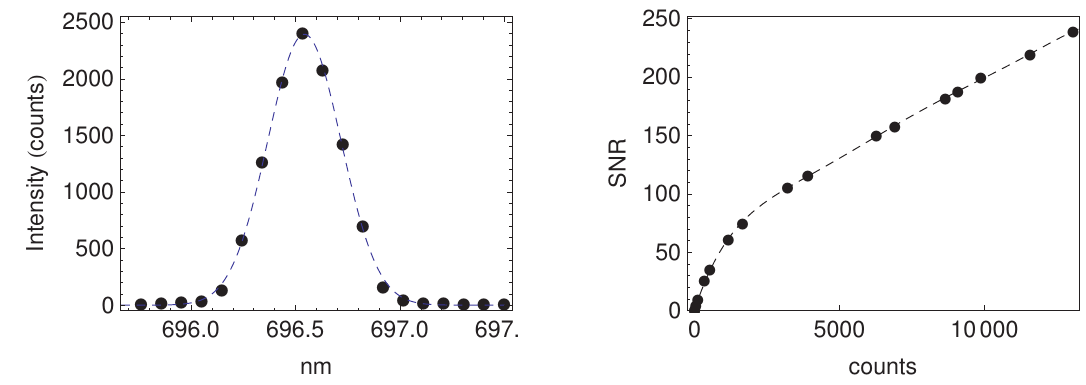
Figure A2. Left : Instrumental spectral function (ISF) of the spectrometer measured at the emission wavelength of the Ar line at 686.8086 nm (full width at half-maximum (FWHM) = 0.41 nm) . Right : Signal-to-noise ratio (SNR) as a function of intensity. The ISF function was fitted with a ∆ λ ) 2 ] . SNR was fitted by a polynomial model as Gaussian model as ISF ( ∆ λ ) = exp [ − 2 ln2 ( FWHM SNR ( x ) = − 2867.57 x 6 + 10418.8 x 5 − 14967.1 x 4 + 10788.2 x 3 − 4099.82 x 2 + 964.652 x + 1.30587, where x is the output value of the spectrometer.